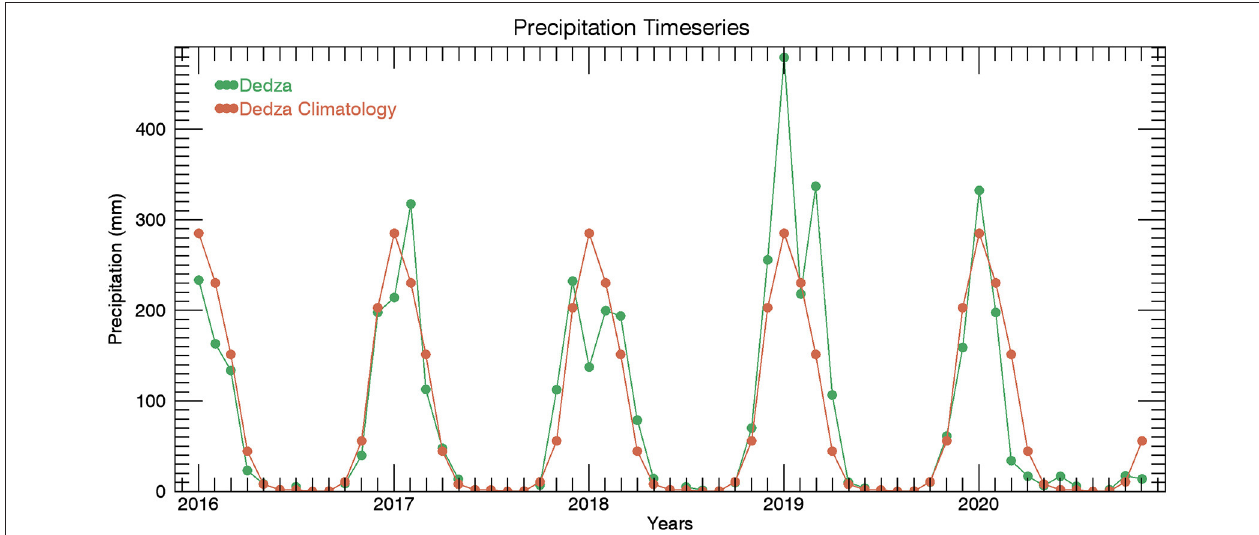
FIGURE 1 | Precipitation (green) and average (2000–2020) monthly precipitation (orange) from CHIRPS for a 5km pixel in an agricultural part of Dedza District, Malawi, 14.34 ◦ S, 34.13 ◦ E.